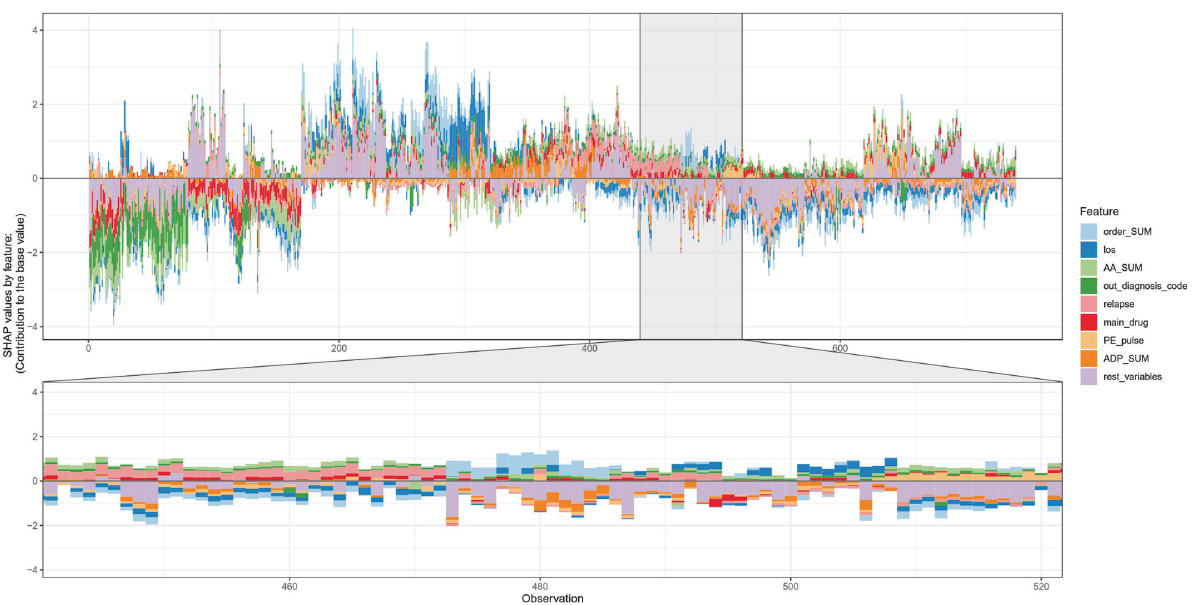
Fig. 6 Force plot of all features at individual patient level for the holdout test dataset of the 30-day